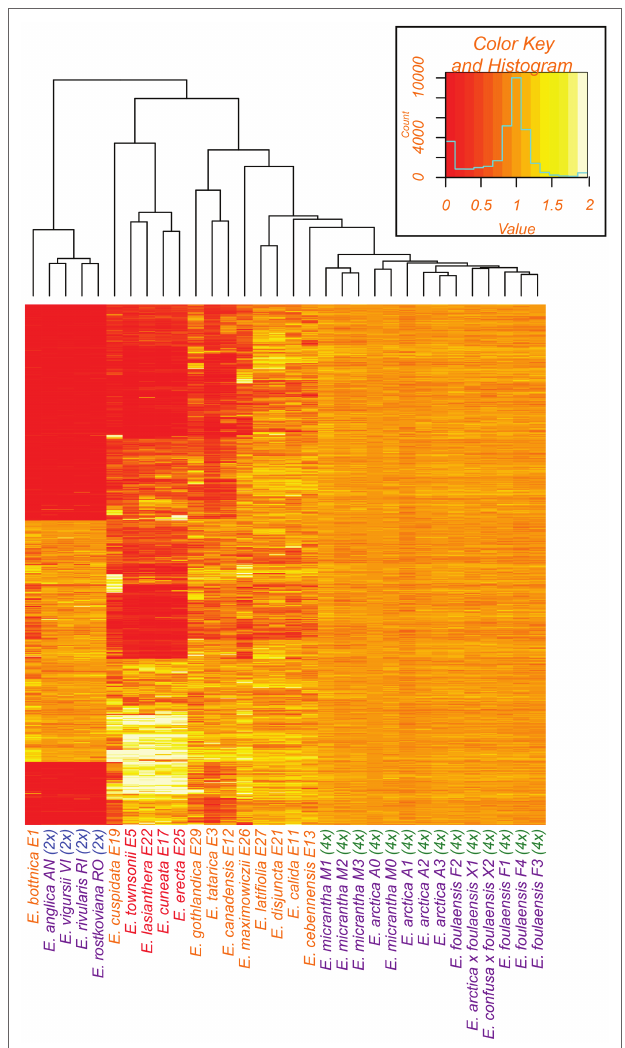
FIGURE 7 | Heatmap of relative mapping depth of Euphrasia whole-genome resequencing data relative to the E. arctica reference genome. Blocks of color represent mapping coverage (see key, top right) for each scaffold along the y-axis. Species names are colored by geographic area and ploidy as in Figure 1 . The tree is based on hierarchical clustering of pairwise Manhattan distances between the samples’ mapping depth